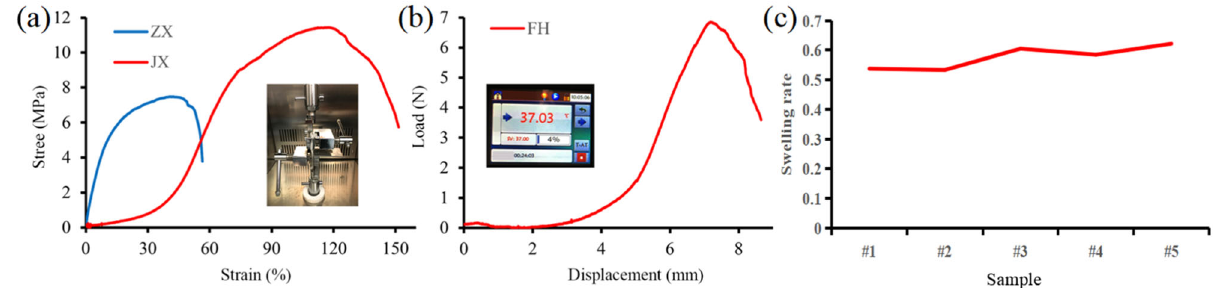
Fig. 7 Mechanical properties of bioarti fi cial blood vessel: a Tensile performance. ZX and JX are the axial tensile curve and radial tensile curve, b Load-displacement curve for suture force. FH is the suture